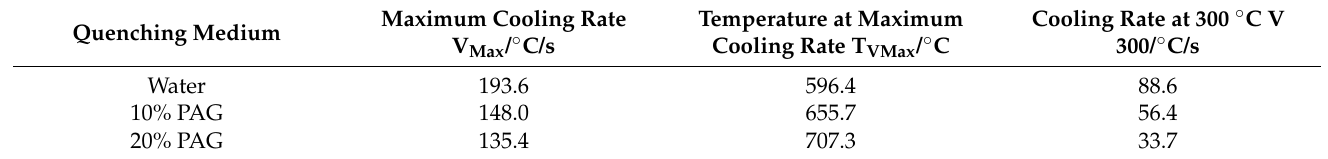
Figure 1. Cooling curves of different quenching mediums during quenching at 20 °C. Table 3. The cooling characteristics of different quenching mediums at 20 °C.